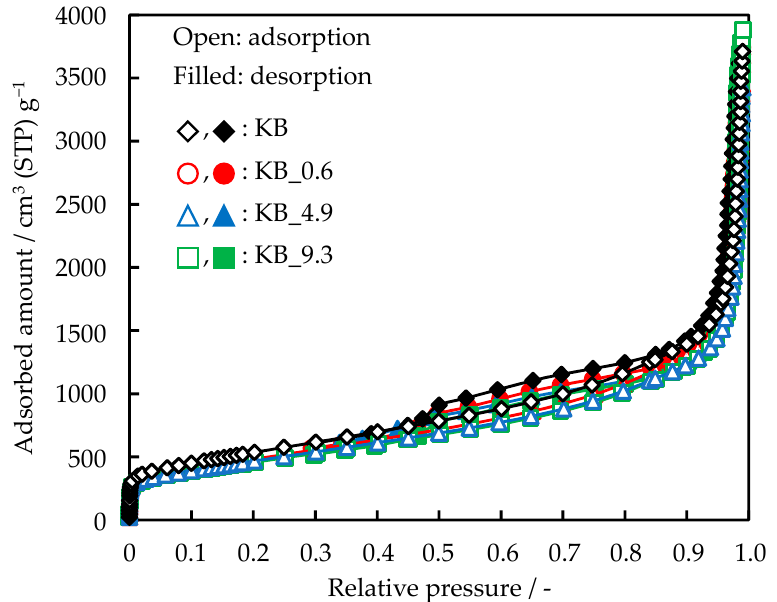
Figure 1. Nitrogen adsorption-desorption isotherms at 77 K for KB, KB_0.6, KB_4.9, and KB_9.3. Differential PSDs for KB, KB_0.6, KB_4.9, and KB_9.3 are shown in Figure 2. In the